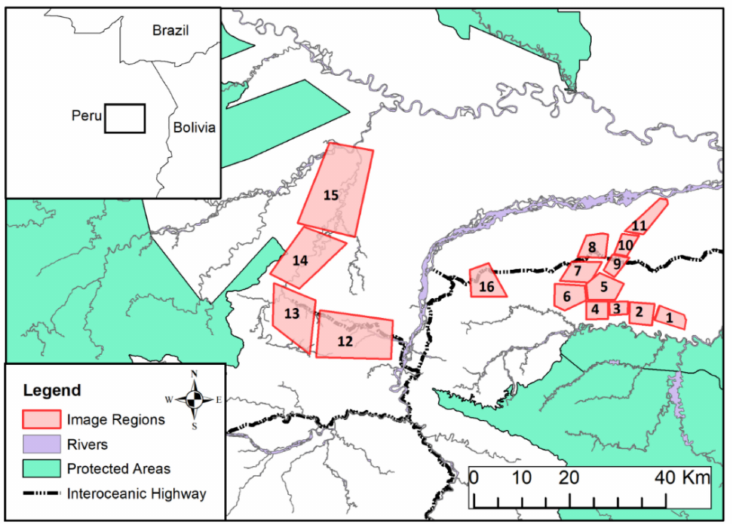
Figure 2. Selected sixteen region samples are shown with different transparent colors in the Madre de Dios (MDD), Peru area on Google Earth Engine (GEE) seen on 23 July 2021. For more geographical details about each region sample, see Table A1 in Appendix A and Figure A1 in Appendix